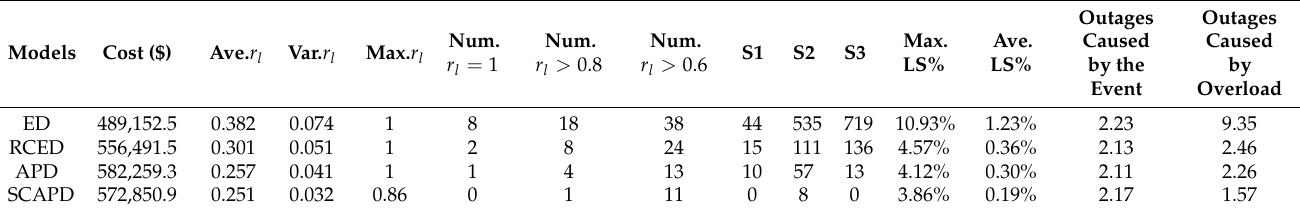
Table 7. Pre-contingency and post-contingency power flow distribution indices and cascade blackout simulation results for different models tested on the IEEE 118-bus